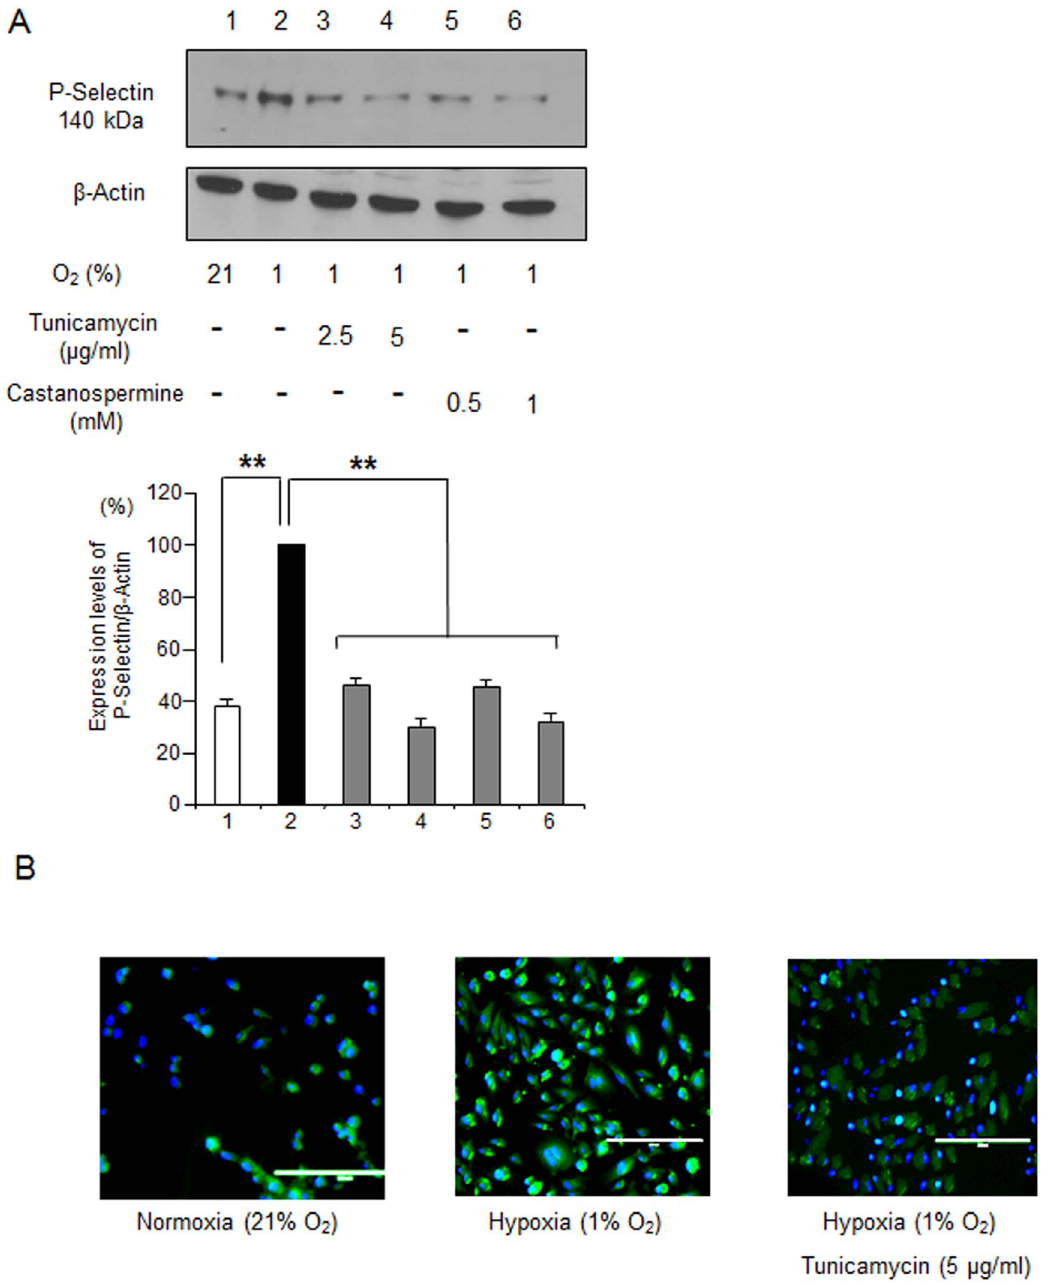
Figure 3. Glycosylation inhibitors block hypoxia-induced P-selectin expression in HUVECs. P-selectin expression in HUVECs exposed to 1% O 2 was examined by Western blotting (A) and immunofluorescence (B). A . Western blotting analysis of P-selectin expression in HUVECs exposed to hypoxia. HUVECs were cultured in the absence or presence of 2.5 or 5.0 m g/mL tunicamycin or 0.5 to 1.0 mM castanospermine, treated with 1 U/ mL thrombin, and then were exposed to 1% O 2 for 1 hour. Cell lysates (30 m g) prepared from HUVECs were analyzed by Western blotting as described in Materials and Methods. b -Actin was as the loading control. The ratio of the P-selectin protein level to that of b -actin was set to 100%. Note that this experiment focused on the expression of the 140 kDa band in response to hypoxia. **, p , 0.0001 B . P-selectin expression on HUVECs by immunohistochemistry. HUVECs were permeabilized and fixed as described in Materials and Methods. Note that expression of P-selectin (green) was induced by exposure to 1-hour hypoxia (1% O 2 ), but by pretreatment of 5 m g/mL tunicamycin.